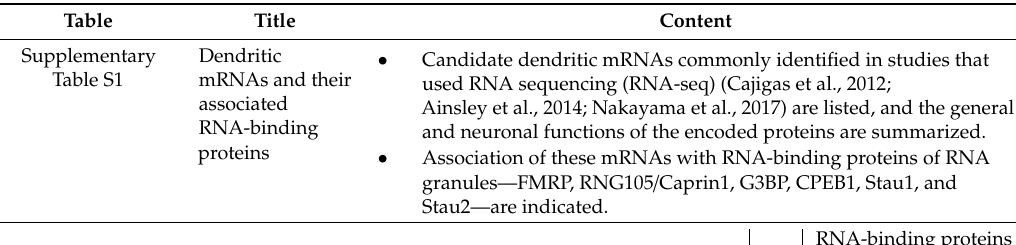
Table 1. Summary of Supplementary Tables S1 and